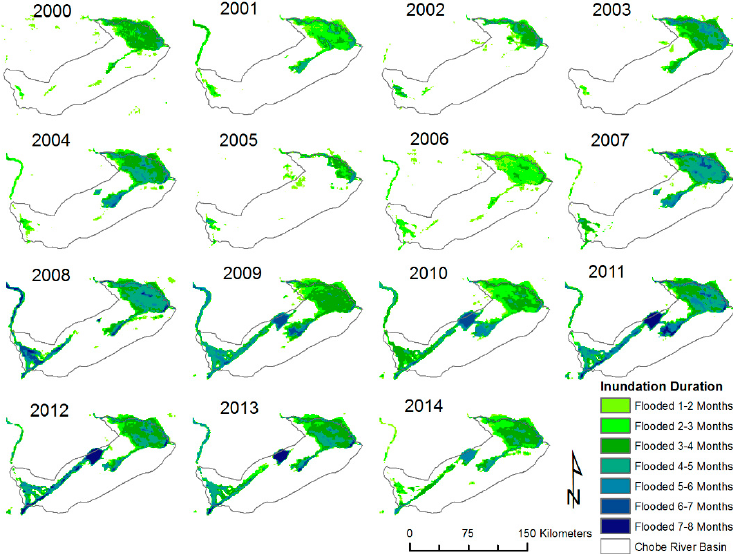
Figure 6. Spatial extent of inundation duration cycles in the Chobe River Basin calculated from MODIS LST data for the period 2000–2014. Areas within the CRB limit that are white reflect no flooding.